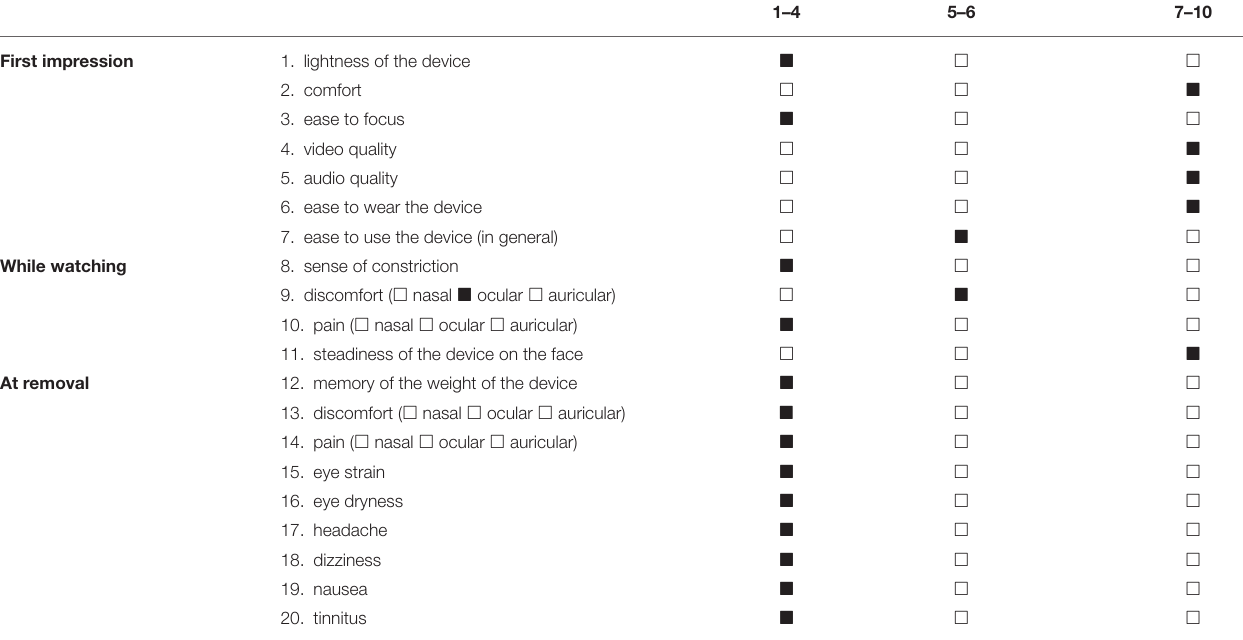
TABLE 2 | Sample of the evaluation sheet showing the mean mark for each